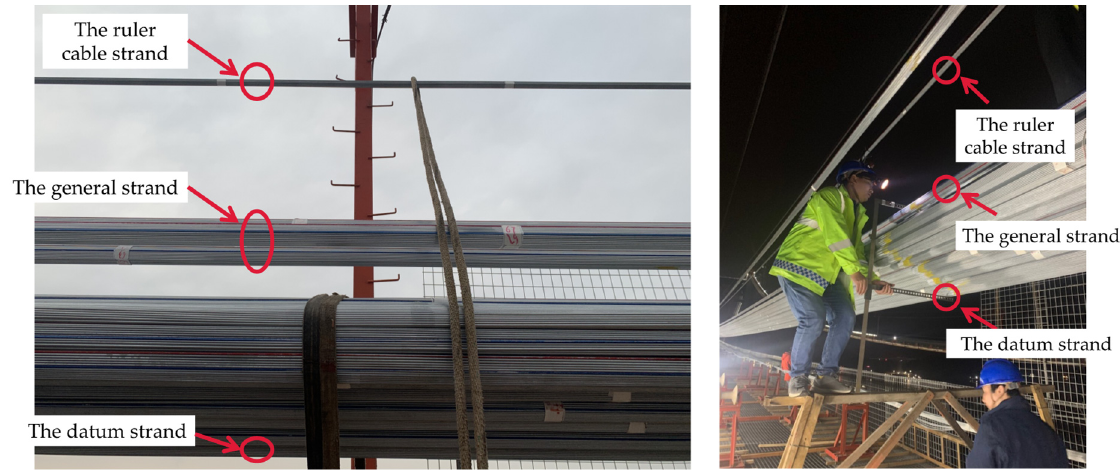
Figure 1. Photos of the field measurement method.